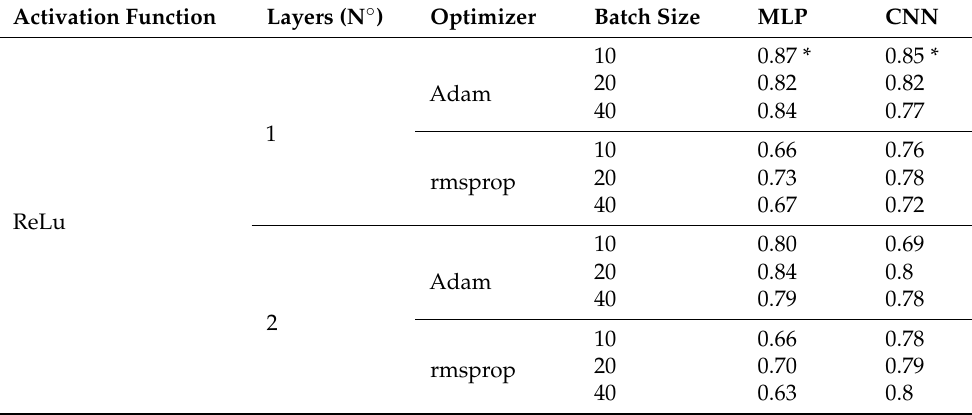
Table 2. Classification accuracy of genetic subpopulation memberships performed in a provenance– progeny trial of eucalyptus. Thirty-six MLP (multilayer perceptron) and CNN (convolutional neural network) models were trained considering the following hyperparameters: activation function (ReLU, Tanh, and Sigmoid), number of layers (one or two dense layers in MLP and one or two extra dense layers in the CNN), optimizer (Adam or rmsprop), and batch size (10, 20, and